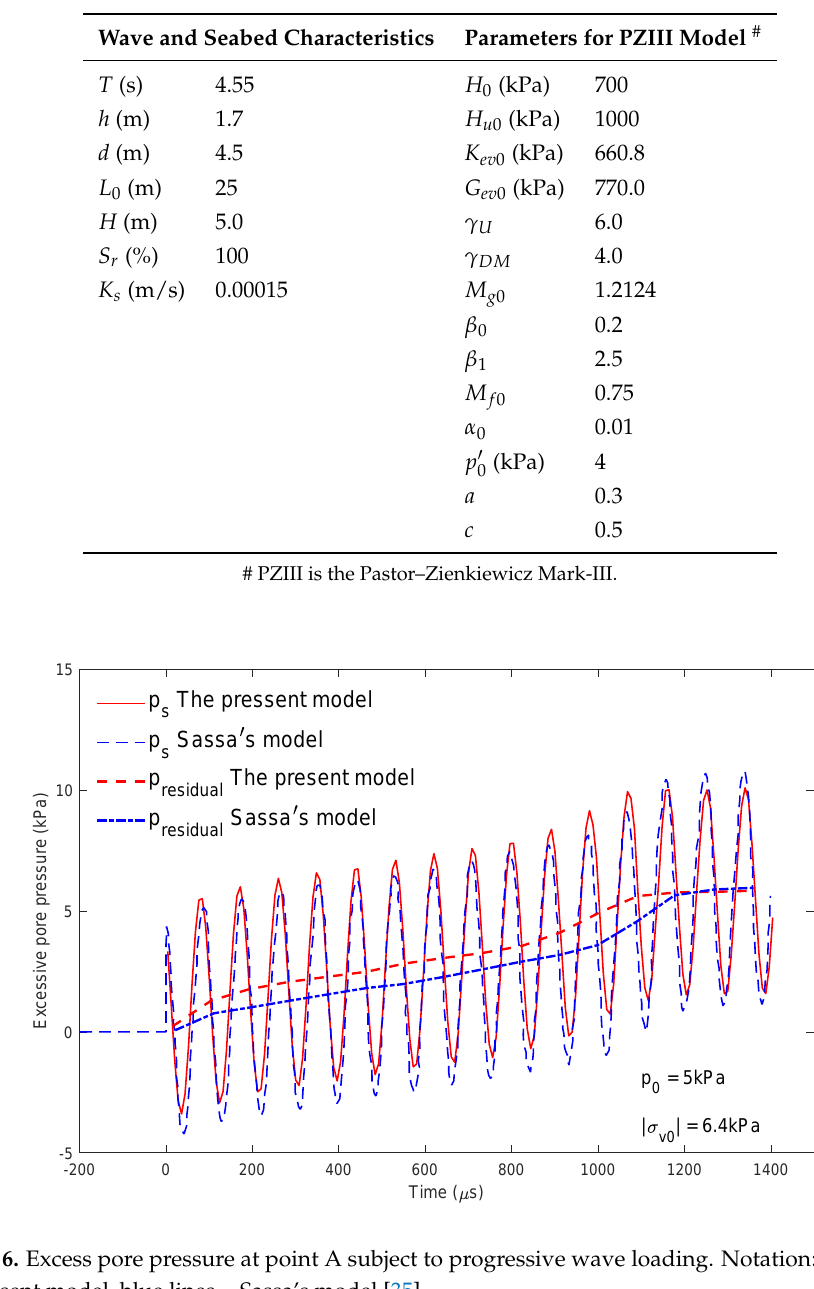
Table 2. Parameters used for comparison between the centrifugal test and numerical model.